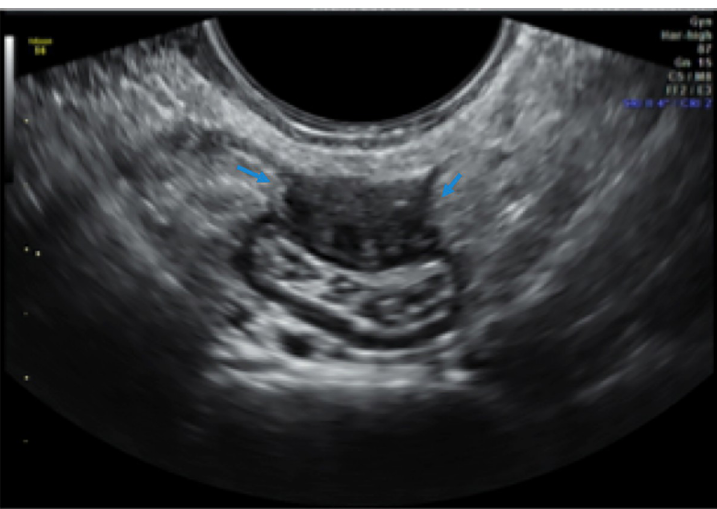
Fig 3. USTVBP image showing an axial section of the rectosigmoid segment. Deep endometriosis nodule in the anterior wall with circumferential involvement of about 30% (blue arrows). aware of the USTVBP result. All surgeries were performed laparoscopically using a high-defi- nition (HD) camera and a Xenon Nova 300 W light source, both from Storz. Access to the abdominal cavity was obtained using the closed technique with a Veress needle, incision of the umbilical scar and subsequent umbilical puncture with an 11-mm trocar. Three accessory punctures were performed with 5-mm trocars in the usual triangular arrangement. CO used to distend the cavity, and the surgeries were recorded on DVD. The surgeries followed the standard procedure of our institution [20], including the dissection of the retroperitoneal spaces, isolation of the ureters and nerve preservation. During the surgical procedure, har- monic energy and bipolar energy were used for dissection and coagulation as needed. All extra intestinal foci of endometriosis was removed prior to treatment of the intestinal nodule.